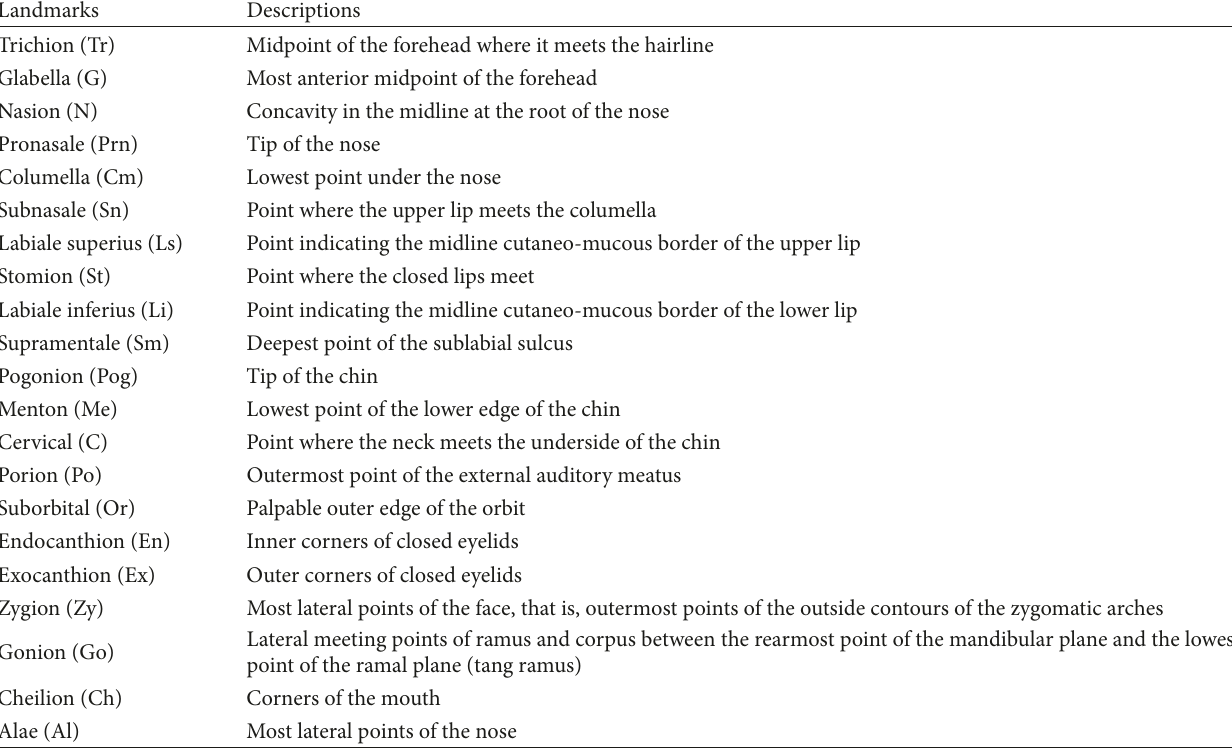
Table 1: Description of landmarks.